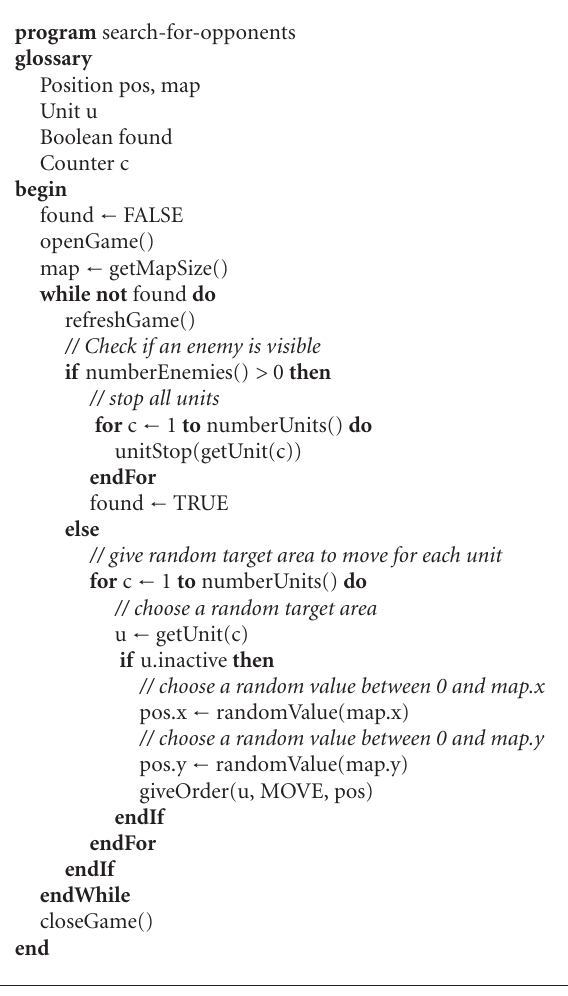
Algorithm 3: “Search for opponent”